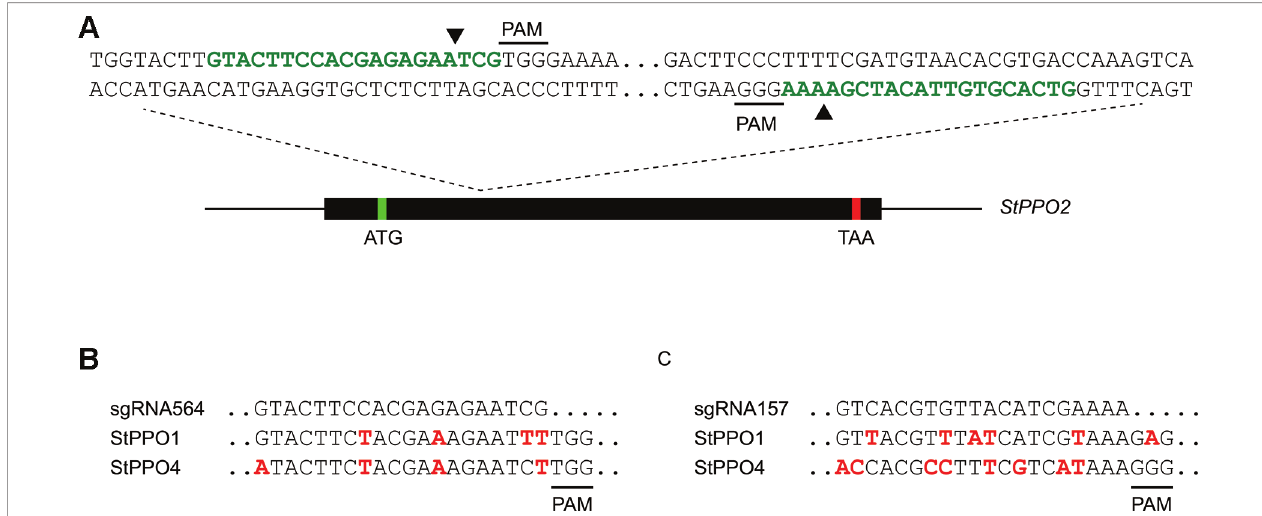
FIGURE 1 | sgRNA design on the StPPO2 gene and off target prediction (A) The structure of StPPO2 gene is shown with the theoretical positions of the start (ATG, green box) and stop codons (TAA, red box). The partial sequence used for sgRNA design is shown above the gene structure. Targets sites for sgRNAs are marked in green letters and the PAM (5 ′ -NGG-3 ′ ) of each target site is indicated. Black arrowheads indicate the predicted cut site for the Cas9 nuclease (B) Predicted off target sites for sgRNA564 on StPPO1 and StPPO4 genes, with mismatches marked in red letters (C) Alignment of sgRNA157 with StPPO1 and StPPO4 genes, with mismatches marked in red